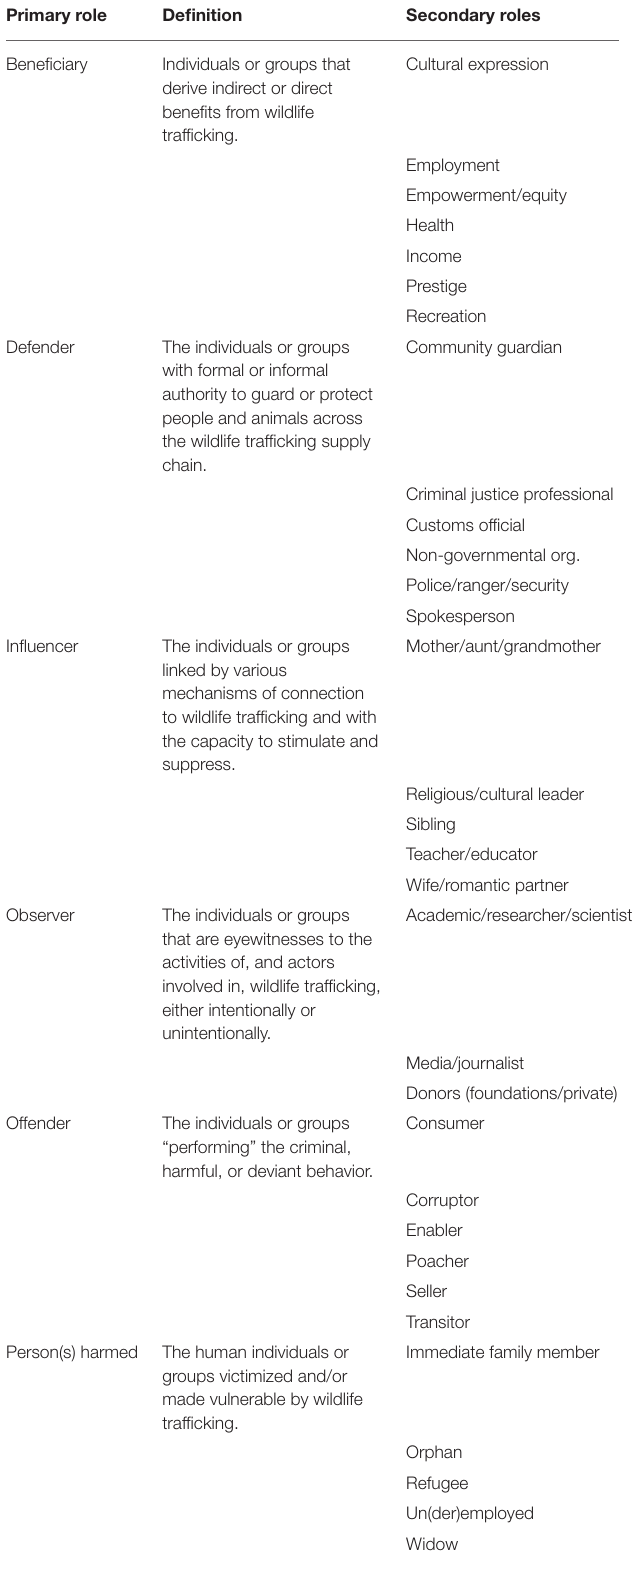
TABLE 1 | Definitions of the primary roles of women in wildlife trafficking and their corresponding secondary roles, alphabetized. Primary